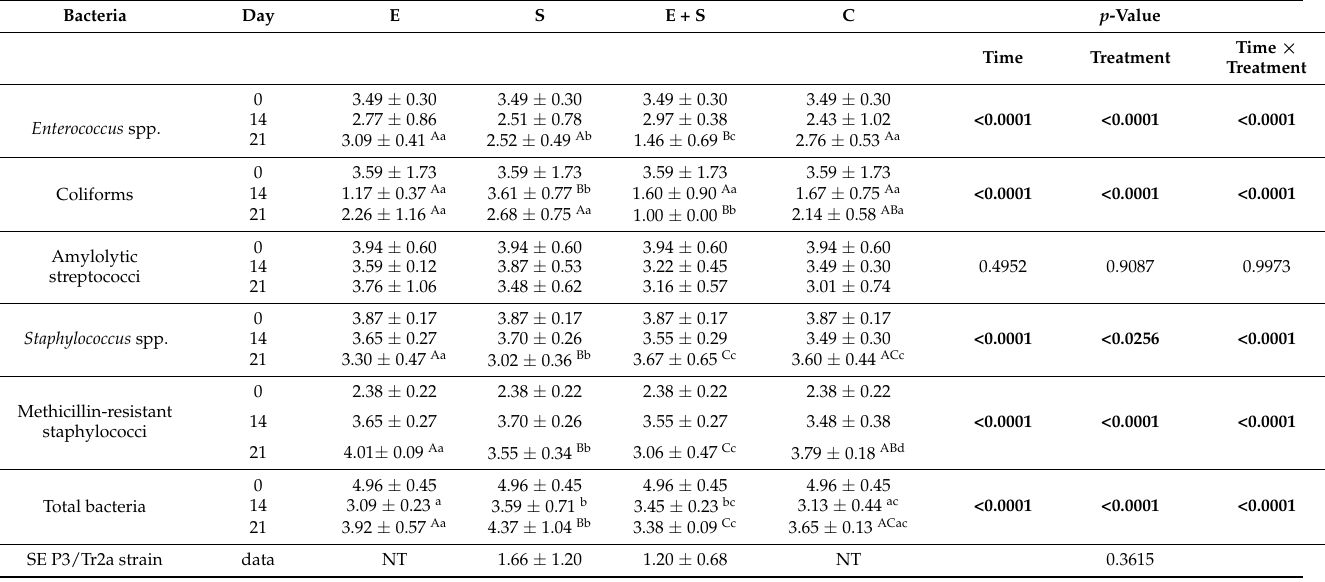
Table 3. Bacterial counts (log 10 CFU/g ± SD) in feces of